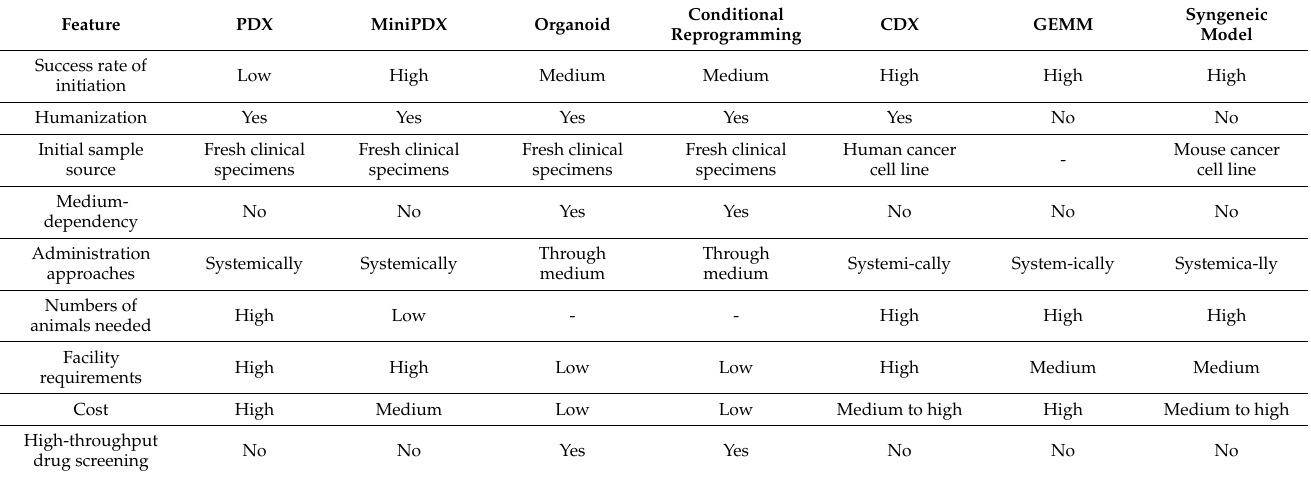
Table 1. Characteristics of cancer models. The advantages and limitations of the cancer models mentioned are listed in Table 1, including features of biology, methodology, and